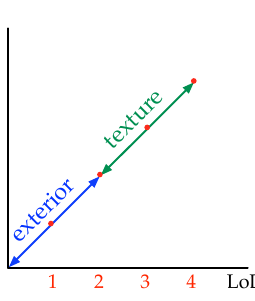
Figure 6: Viewing LoDs as a composition of multiple SLoDs. Example for CityGML and BLOM3D.